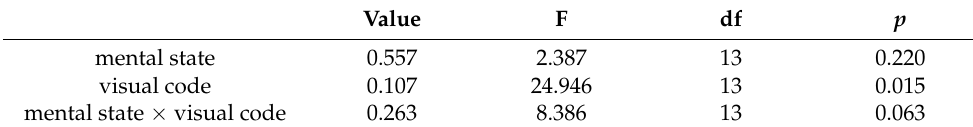
Table 6. Multivariate ANOVA results for P200 mean amplitude of mental state and visual code.